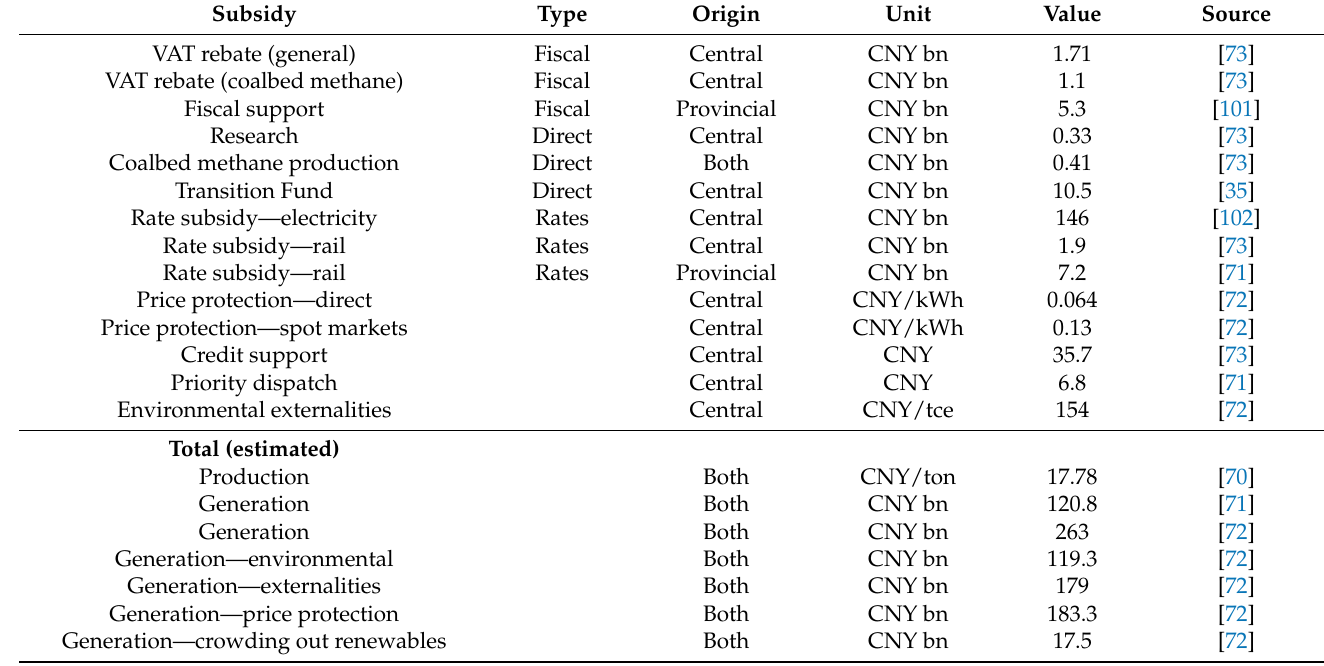
Table A17. Estimated annual subsidies to the coal